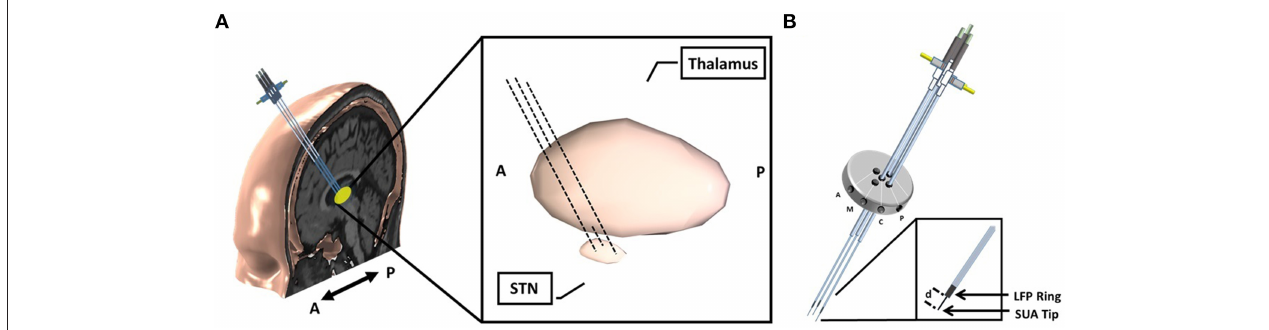
FIGURE 1 | Implantation of microelectrodes into STN using 3 simultaneous tracks. (A) Schematic of 3-track- microelectrode implantation into STN. The schematic in the middle shows the 3D-structure of STN and thalamus. The anatomical structures are viewed from sagittal plane. (B) Schematic of 5-port Bengun routinely used in STN localization in PD and penetration of multiple microelectrodes through the Bengun. Among these three tracks, optimal track is used as the DBS electrode implantation track. The LFP recording surfaces of both AO recording microelectrode (NeuroProbe, AlphaOmega Inc., USA) and FHC microelectrode (MicroTargetingTM, FHC, Inc., USA) are identical with a 1mm stainless steel semi-macro contact situated 3 and 1mm proximal to the micro-recording tip (electrode offset “d”), respectively. A, anterior; M, medial; C, center; P, posterior. The fifth trajectory, not visualized in the figure, is